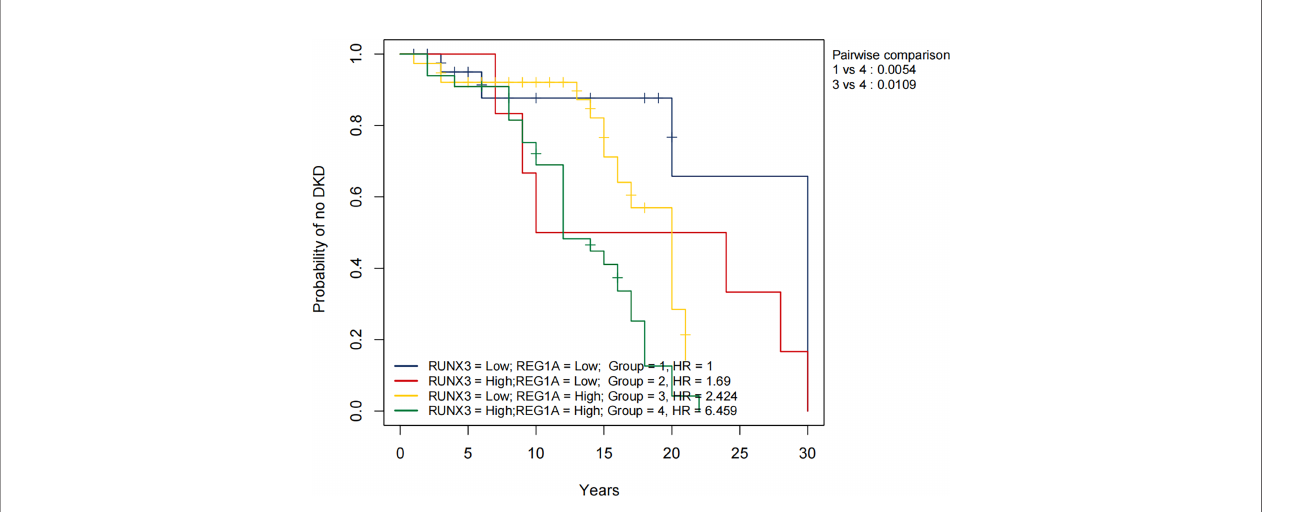
FIGURE 8 | Overall KM curves using combinations of REG1A and RUNX3 expression levels. Univariate Cox regression was used to determine HR; log-rank p- values reported; Bonferroni multiple testing adjustment for pairwise comparisons. REG1A high and low cut-offs, 0.84; RUNX3 high and low cut-offs 1.45. Time unit (years). HR, Hazard ratio.